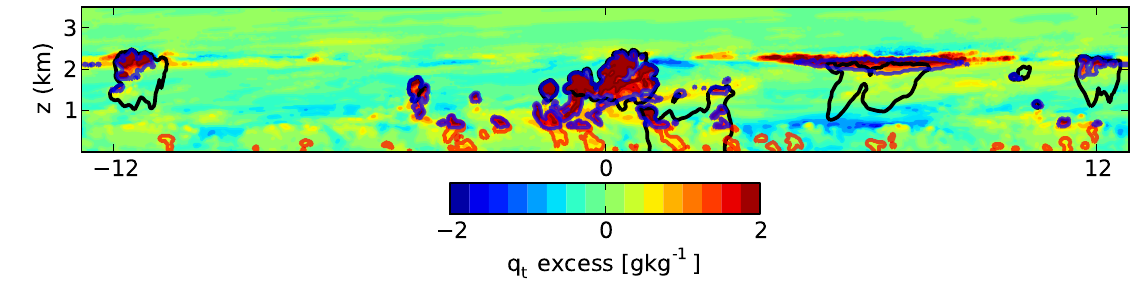
Fig. 3. xz cross section of the simulation at t = 24h. Background color field represents deviations from the mean total specific humidity q t . Red contours depict the thermals, blue contours the clouds, black contours rain patches.